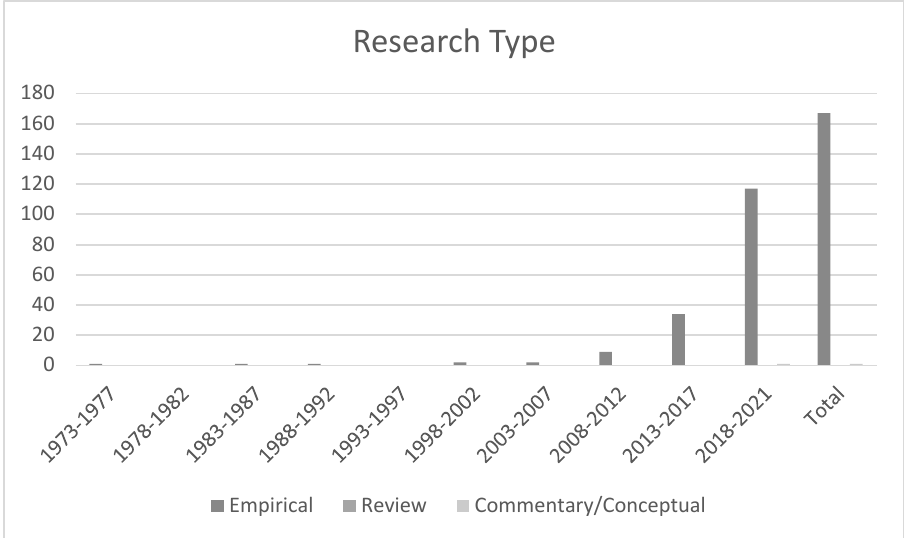
Figure 4. Trend of Research Type by Five-Year Interval during 1973 – 2021 (n = 168).